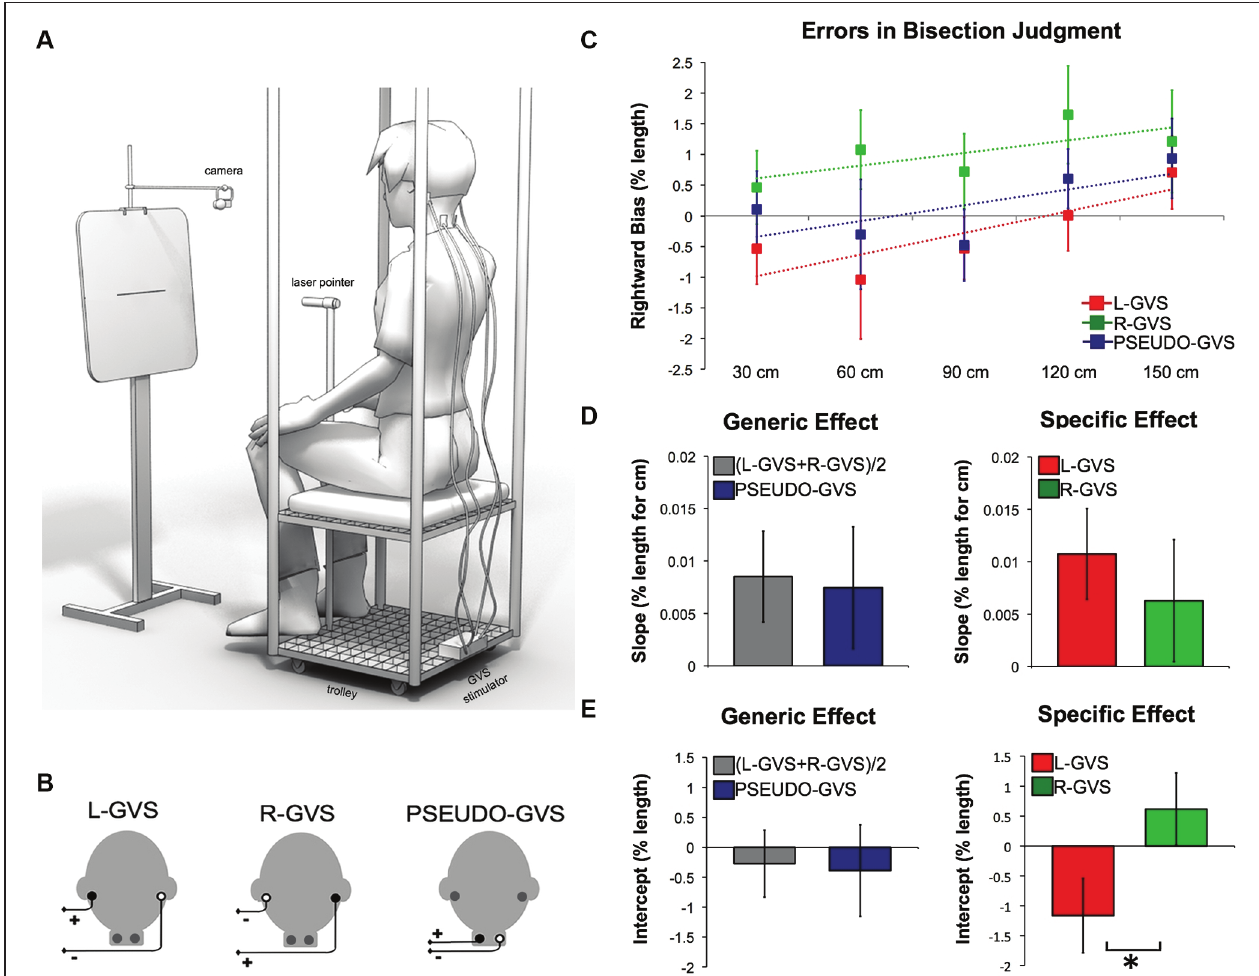
FIGURE 1 | Effects of GVS on spatial perception. (A) Experimental set-up. (B) GVS polarities and electrodes configurations. (C) Errors in bisection judgment. Raw data in each condition in function of the distances and fitted linear regression (dashed lines). (D) Slope data as a function of GVS condition. (E) Intercept data as a function of GVS